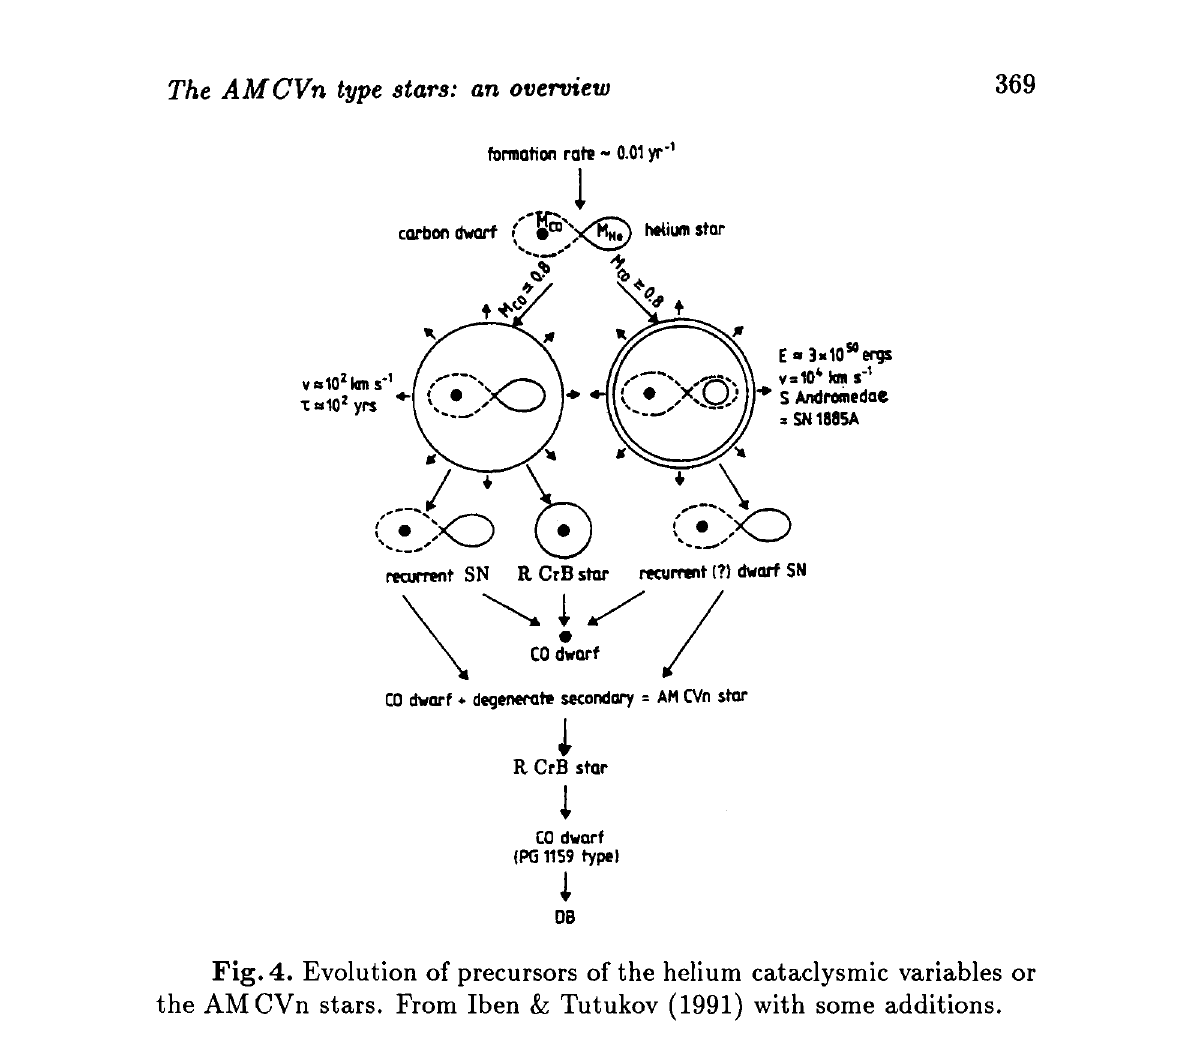
Fig. 4. Evolution of precursors of the helium cataclysmic variables or the AMCVn stars. From Iben & Tutukov (1991) with some